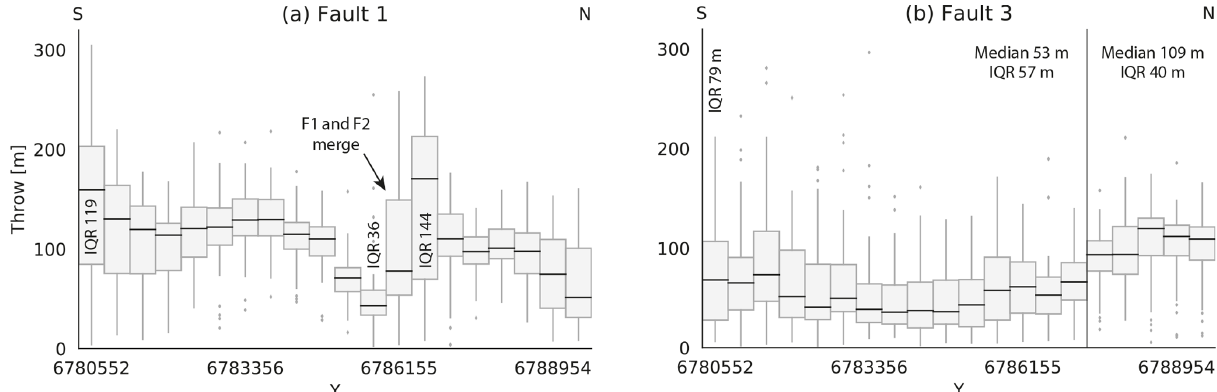
Figure 6. Results of fault throw analysis for Faults 1 (a) and 3 (b) visualized as box plots, showing median fault throw (black lines) with interquartile range (grey boxes), minima and maxima whiskers (grey lines) and outliers (grey dots).